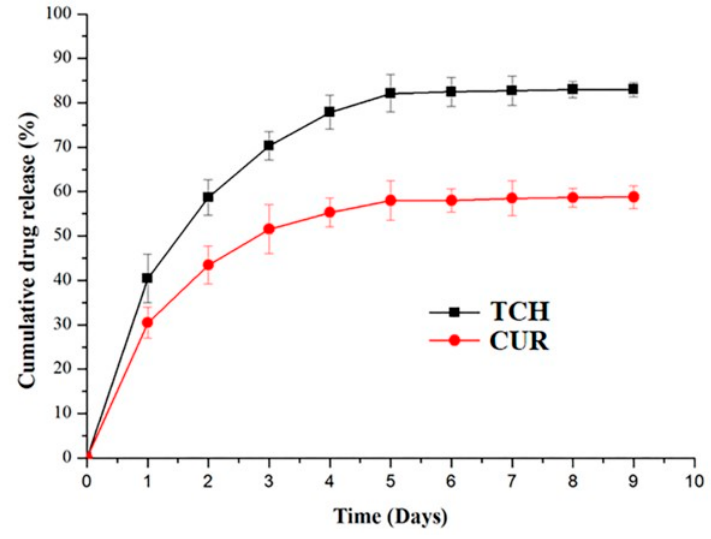
Figure 4. Drug release profile kinetics of PCL/AV/CUR and PCL/AV/TCH nanofibers.